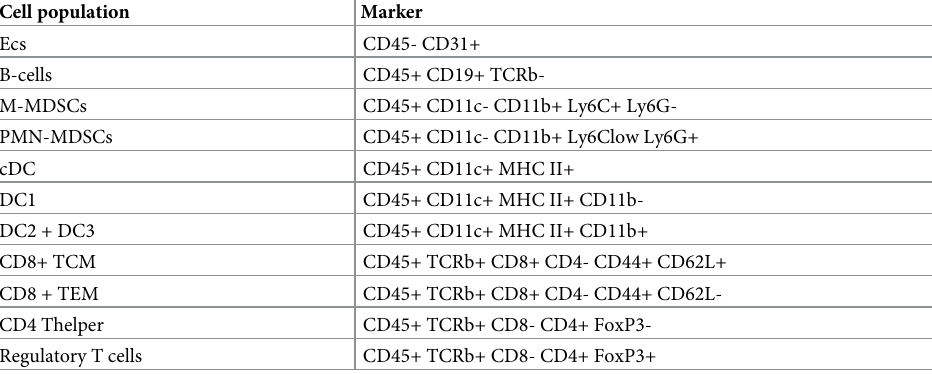
Table 2. Marker used for the identification of immune cell